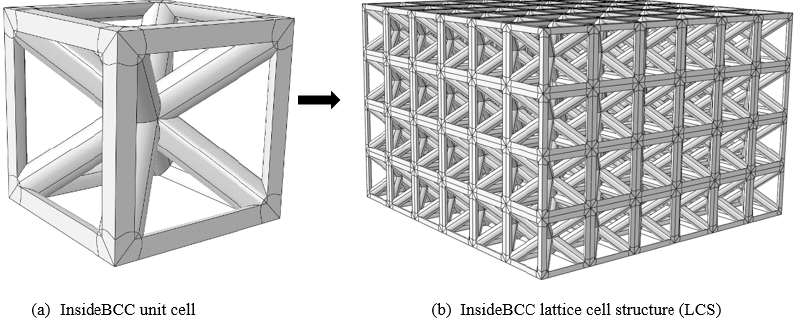
Micromechanics technique design (MTD). ( a ) InsideBCC unit cell. ( b ) InsideBCC lattice structure.